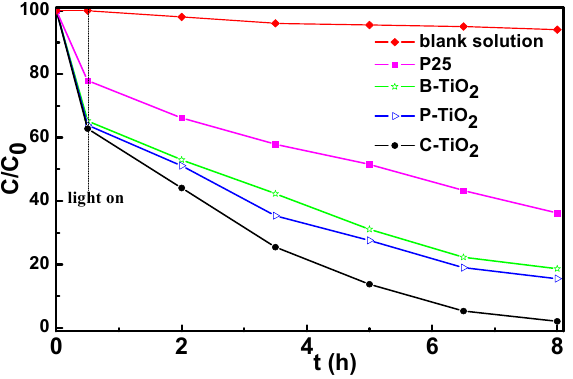
Figure 10. Photocatalytic activities of TiO 2 materials under visible-light irradiation.